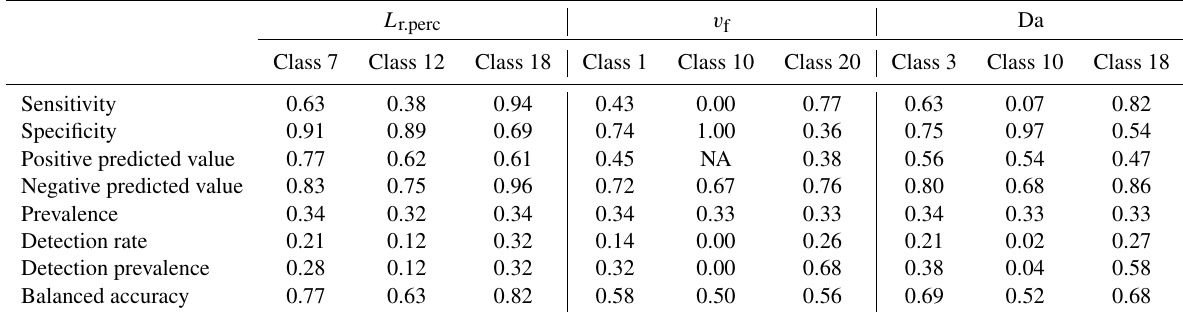
Table C3. Performance statistics for each of the classes for the variables L r.perc , Da and v f predicted by